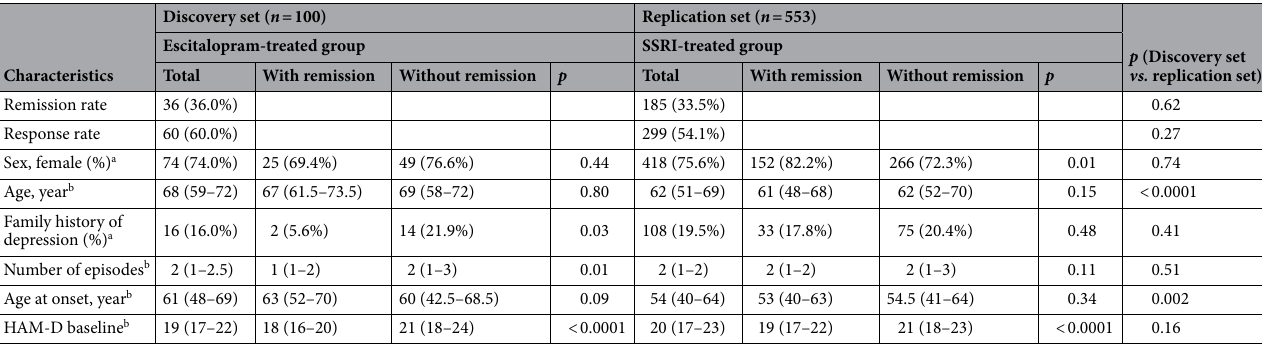
Table 1. Clinical and demographic characteristics of the completer cohorts. HAM-D Hamilton depression rating score, SSRIs selective serotonin reuptake inhibitors. a Chi-square test was performed. b Wilcoxon’s rank sum test was performed. Ranges shown are inter-quartile